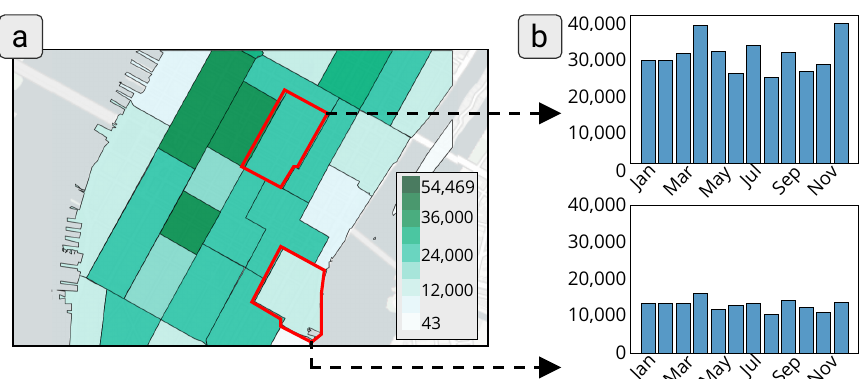
Figure 2. ( a ) A choropleth map showing the number of taxi trips in each neighborhood of Midtown Manhattan (NYC). ( b ) Each of these neighborhoods has an associated monthly distribution of the number of taxi trips, as highlighted for the regions of Midtown Center and Kips Bay ( b